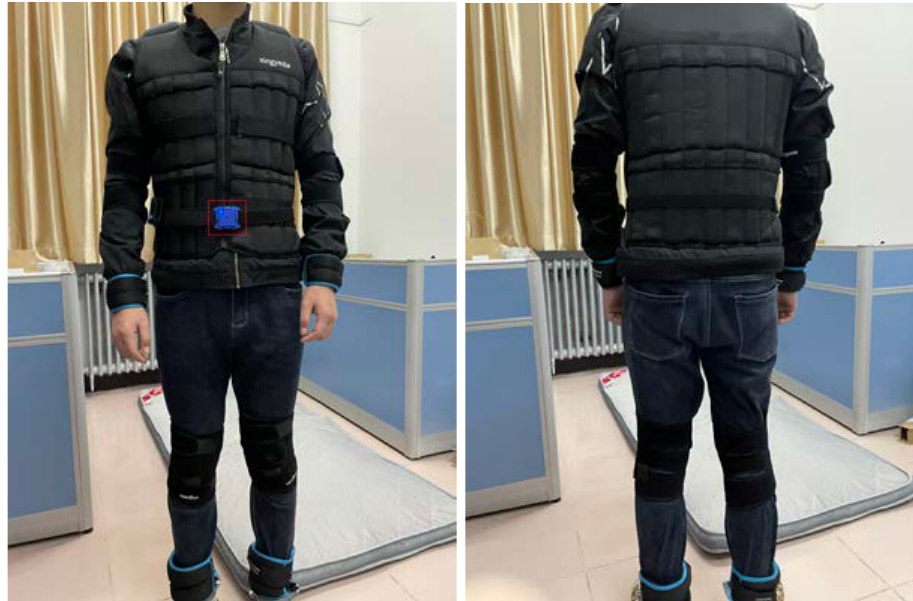
Figure 2. Subjects wore devices for simulated experiments.